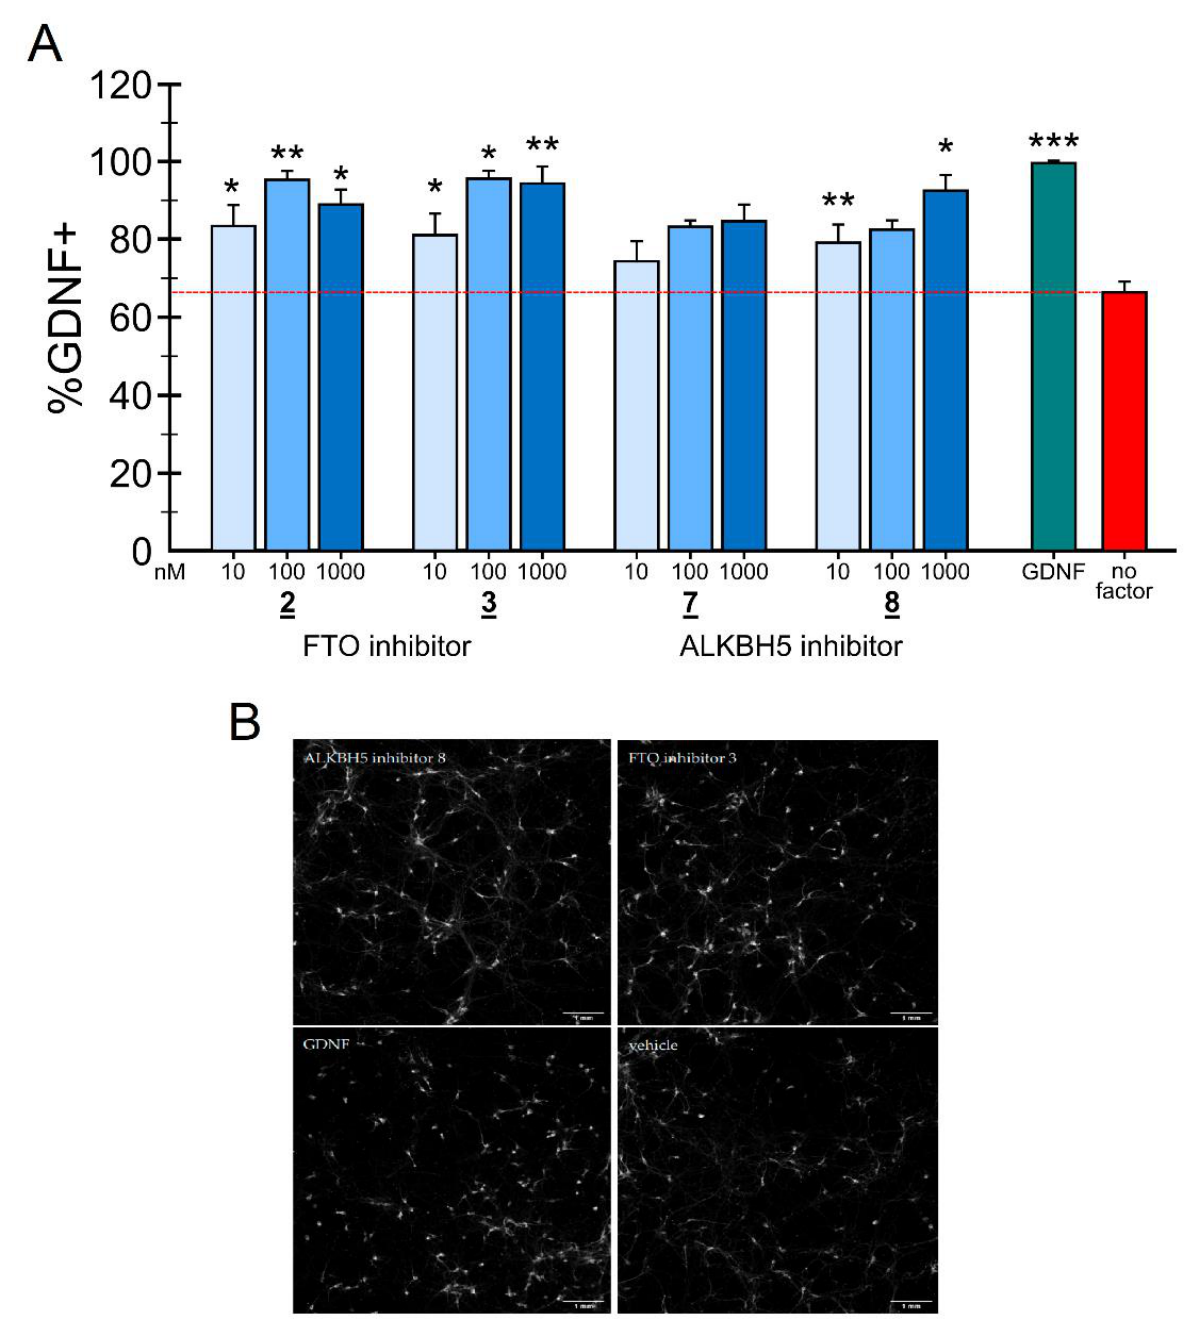
Figure 7. Effect of the FTO inhibitors 2 and 3 and ALKBH5 inhibitors 7 and 8 on the survival of the dopamine neurons. ( A ) The number of TH-positive cells in the wild-type midbrain cultures with growth factor deprivation and treated with vehicle, FTO inhibitors 2 and 3 and ALKBH5 inhibitors 7 and 8 or GDNF normalized to the total number of cells in the culture and presented as percentage of vehicle treated samples, average from 4–5 well from one experiment. Both experiments were repeated three times with reproducible results. Concentration of GDNF used as a positive control is 3 nM (100 ng/mL) and concentration of inhibitors are in nM. No factor—Vehicle. * p < 0.05, ** p < 0.01, *** p < 0.001, one-way ANOVA with Dunnett’s posthoc test. ( B ) Representative images of immunoreactivity for the dopaminergic neuronal marker TH at DIV 5. Scale bars: 1